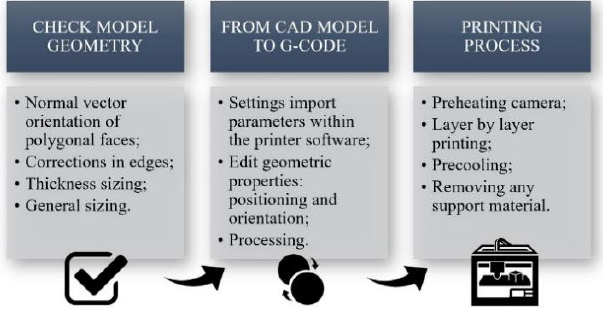
Figure 4. From check model to printing